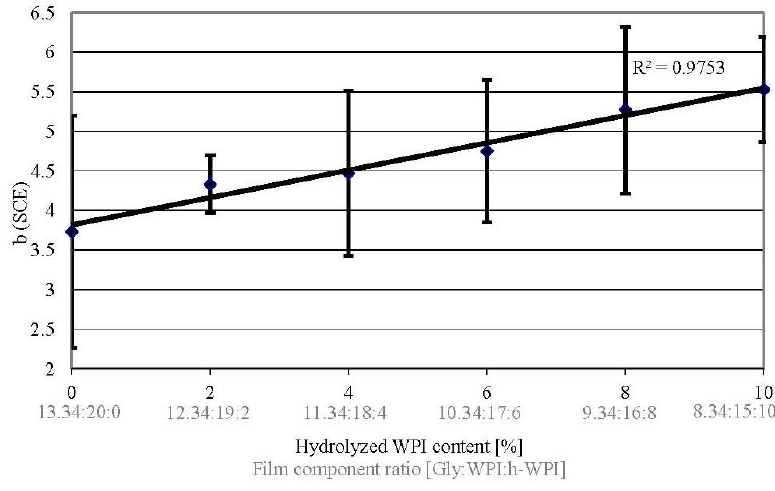
Figure 7. Effect of increased h-WPI content (reduced protein M content on yellow coloration (b-value) of WPI-based